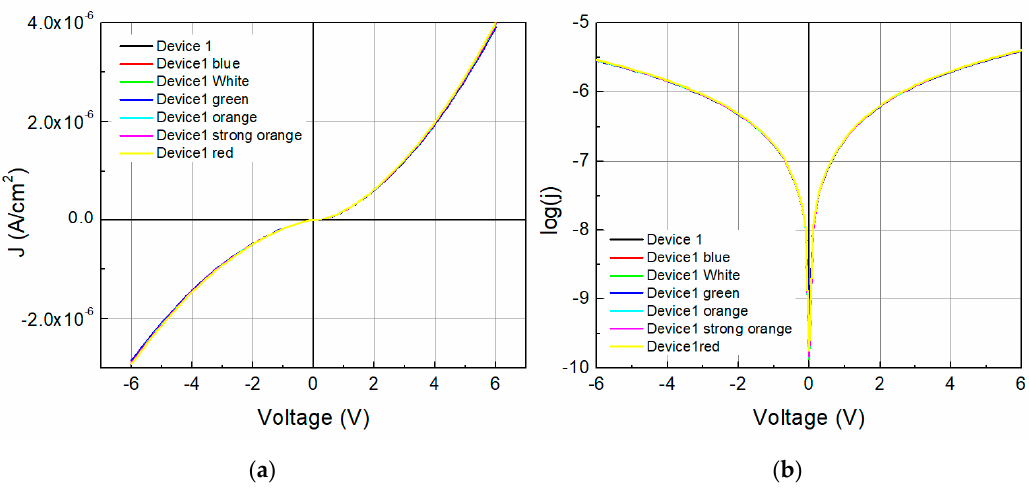
Figure 8. Device 1 ( a ) J-V characteristics and ( b ) log(J)-V curves under illumination.